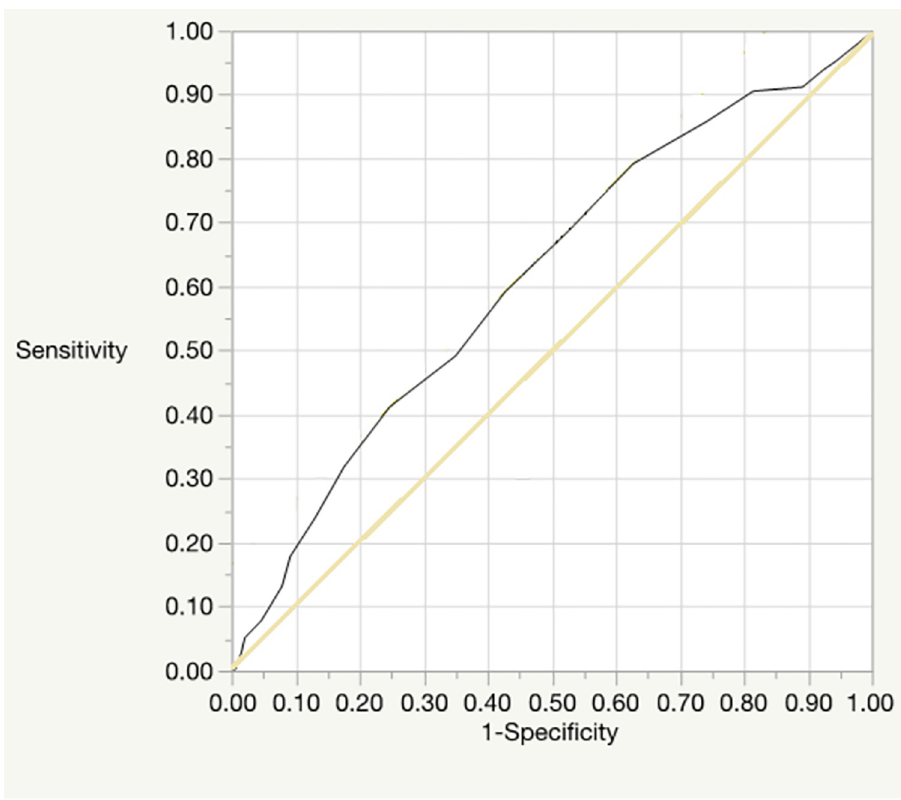
Fig 1. The ROC curve for drug